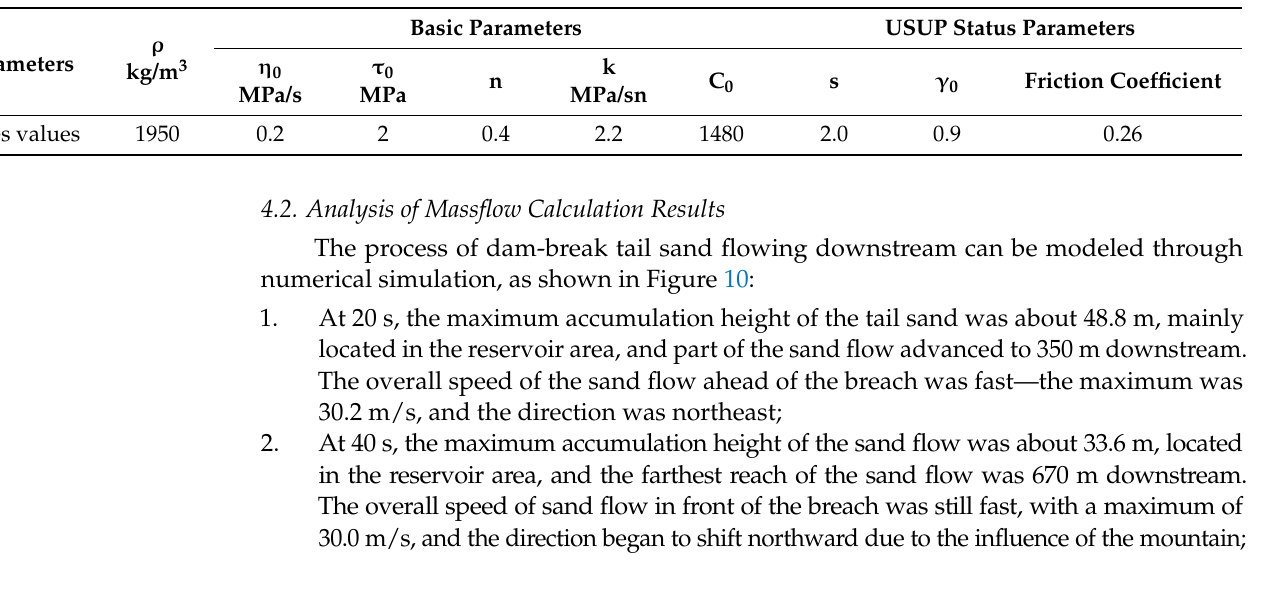
Figure 9. Calculation model. ( a ) Massflow calculation model; ( b ) SPH calculation model. Table 3. SPH calculation